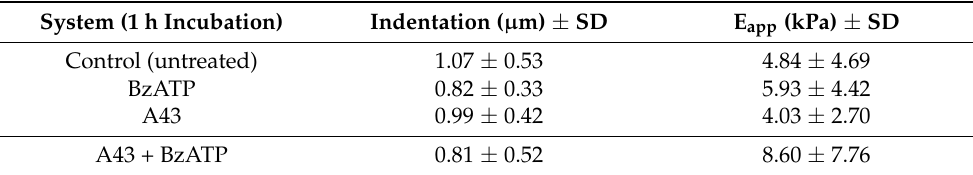
Figure 4. Cerebellar astrocyte nucleotide stimulation influence on approach-derived mechanical factors. ( a ) Cell indentation before maximum load (1.5 nN) achievement and ( b ) calculated apparent elastic moduli (E app ) variation for untreated cells (control, black), and cells exposed to BzATP agonist (green), A43 antagonist (red), or both A43 + BzATP (gradient). The horizontal line indicates the median, and the square refers to the mean value, which are shown numerically in Table 2. Whiskers indicate SD. Statistically relevant variations p < 0.05, and p < 0.001 are highlighted by *, and ***, respectively. Table 2. Statistics on approach segment (mean indentation and apparent elastic modulus). Error values indicate the standard deviation (SD).